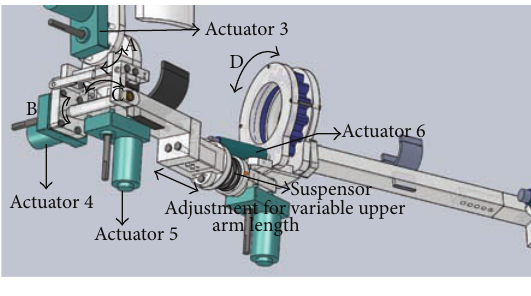
Figure 5: Glenohumeral joint model.